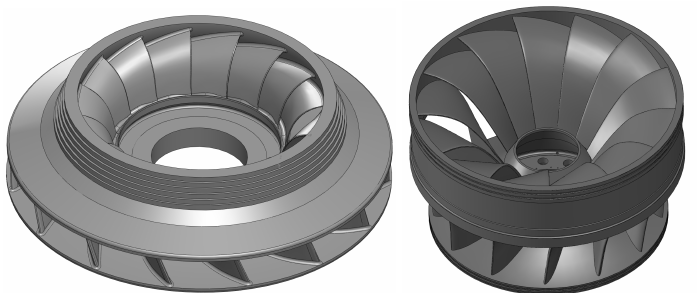
Figure 4. CAD runner models of: pumped storage plant 1 ( left , n q = 25.4 min − 1 ) and hydropower plant 2 ( right , n q = 62.2 min − 1